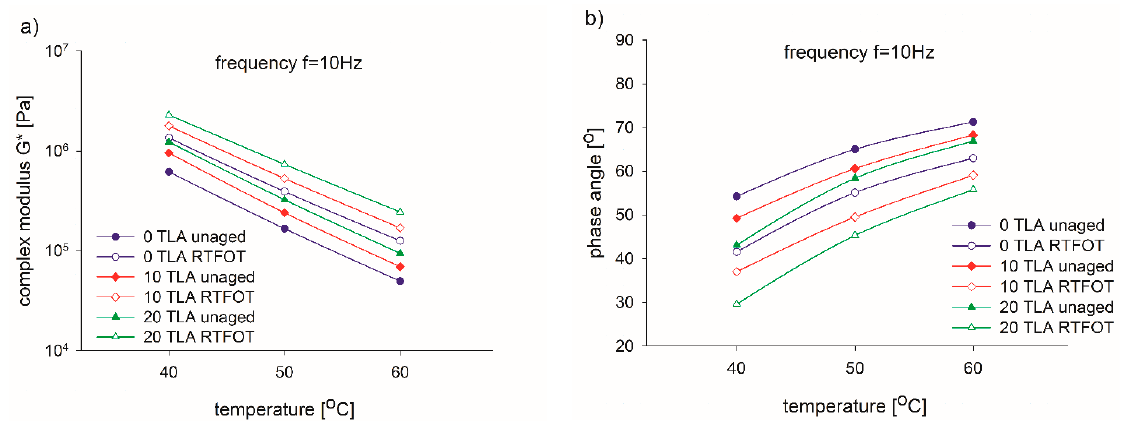
Figure 4. Isochronous curves of the complex modulus ( a ) and phase angle ( b ) of the TLA-modified binders before and after aging.